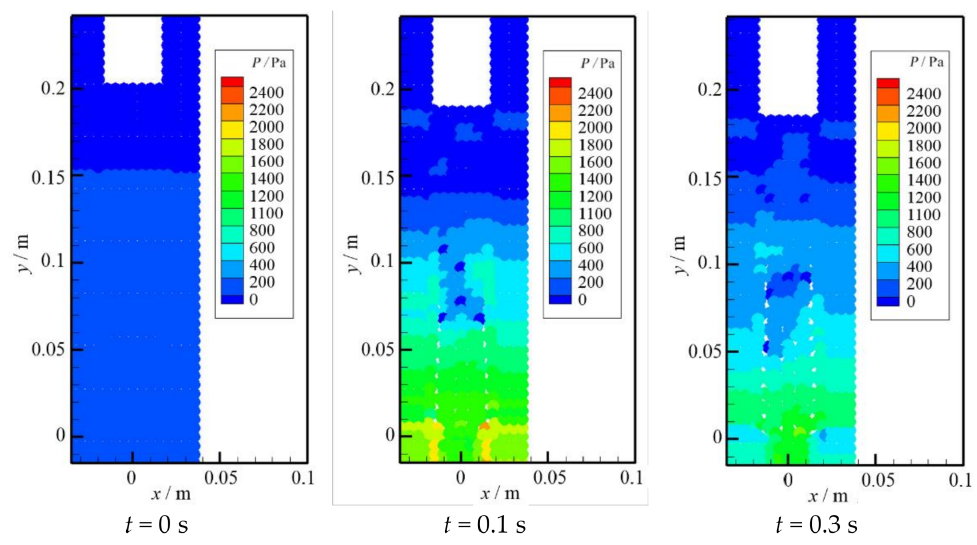
Figure 5. Snapshots of the hydrostatic pressure at different times.